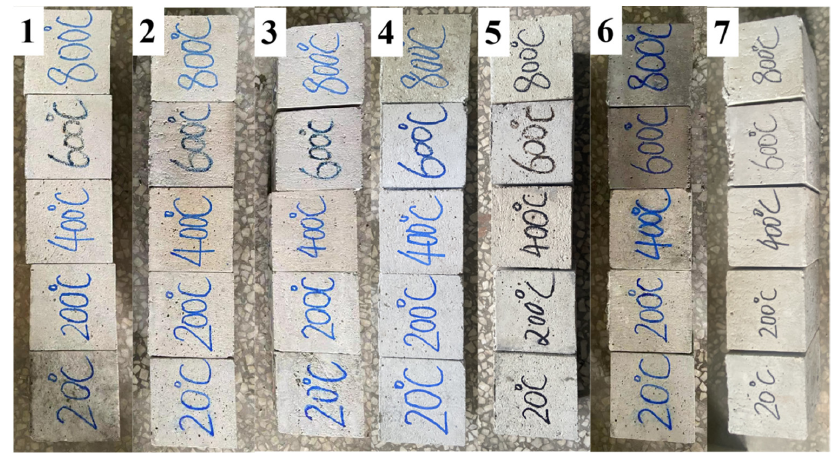
Figure 10. Appearance of concrete specimens before and after high-temperature exposures.